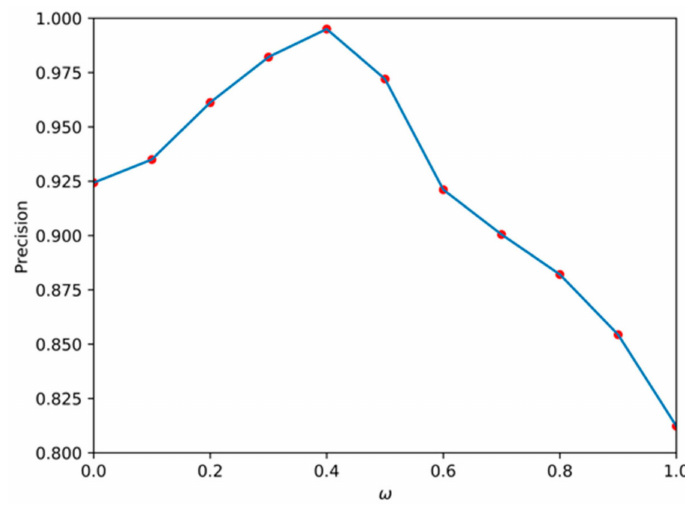
Figure 11. Relationship between the average precision (AP) of SSL detection and ω .